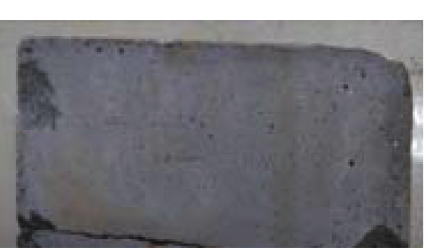
Figure 2: Direct shear test of similar model